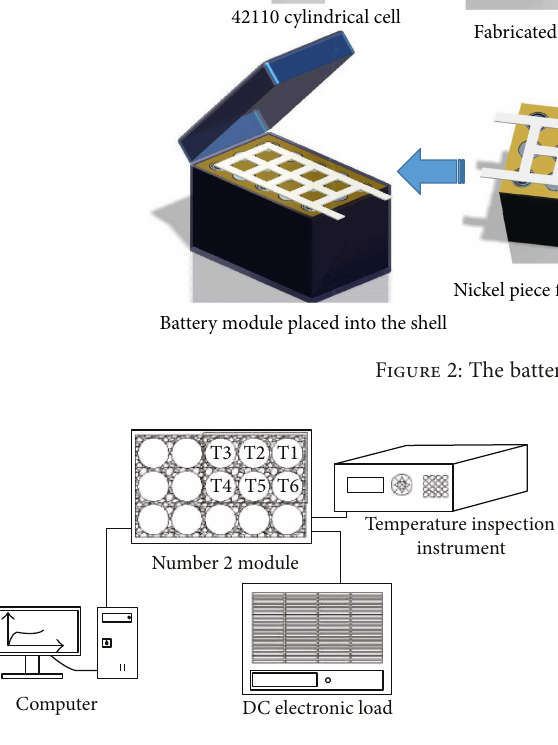
Figure 3: The sketch measurement experiment systems of battery module with PCM cooling.